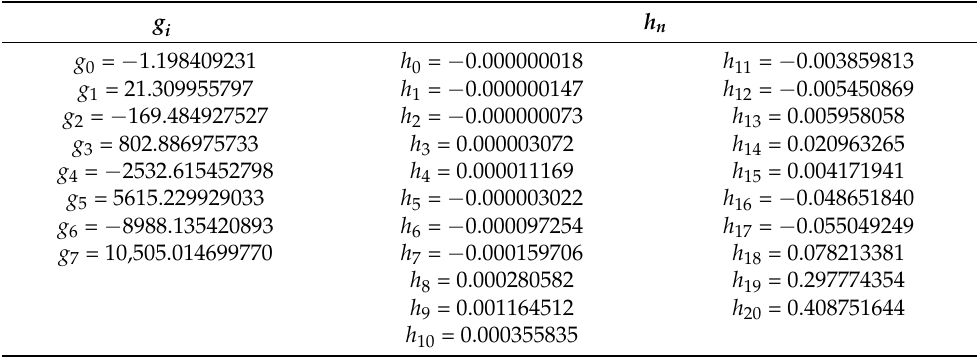
Table 5. Coefficients of the cut off-frequency fixing filter for ( N , K ) = ( 20, 13 ) .